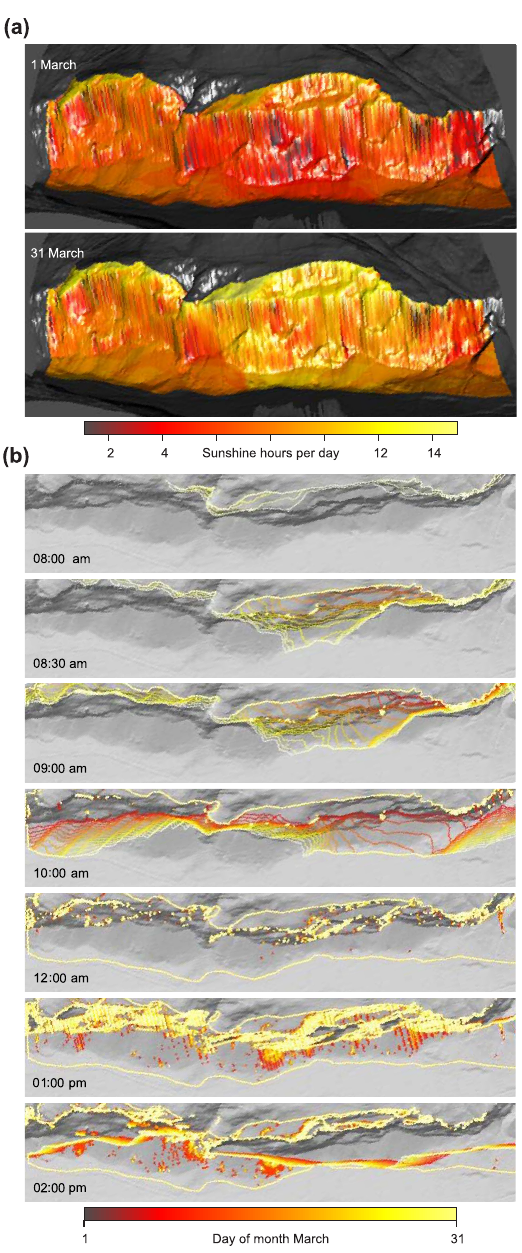
Figure 9. Potential sunshine coverage of the western Lauterbrun- nen cliff face. (a) Cumulative potential sunshine hours for the be- ginning and end of March 2015. The central part of the cliff shows the most changes, from 2–6h on 1 March to 6–14h at the end of the month. (b) Sunlight-covered areas along the cliff face for differ- ent hours of the day (individual panels) and through the course of March 2015 (colour of the lines). The cliff cannot receive sunlight before 8:00, is completely in the sun by 12:00 and in the shadow again around 13:00. Again, the central cliff part is the most sensi- tive between 8:00 and 10:00. Sunlight polygons are clipped to area of interest from Fig.